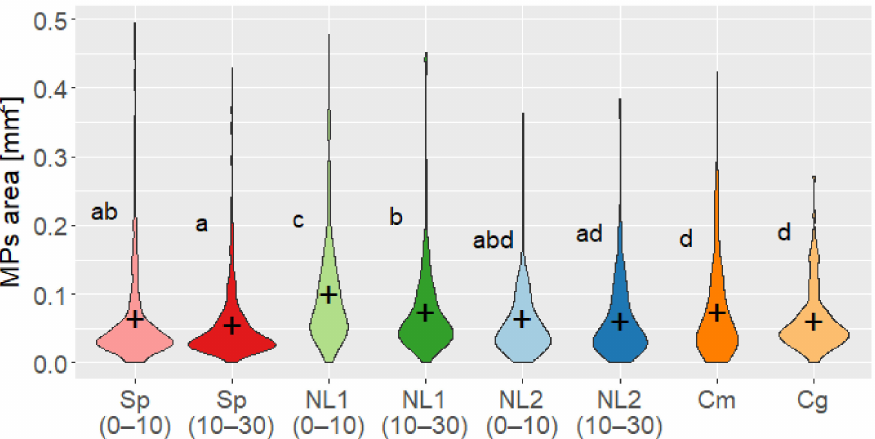
Figure 3. Microplastic particles’ area distribution in agricultural soil of the Spanish farm (Sp) and Dutch farms (NL) for both the top soil (0–10 cm) and the deeper depth (10–30 cm), and for compost samples from municipal waste (Cm) and from green cuttings (Cg). Only particles < 0.5 mm 2 are plotted for a better visualization. The cross indicates the mean particle area. Treatments that do not share letters are significantly different from each other (Kolmogorov-Smirnov test at p <